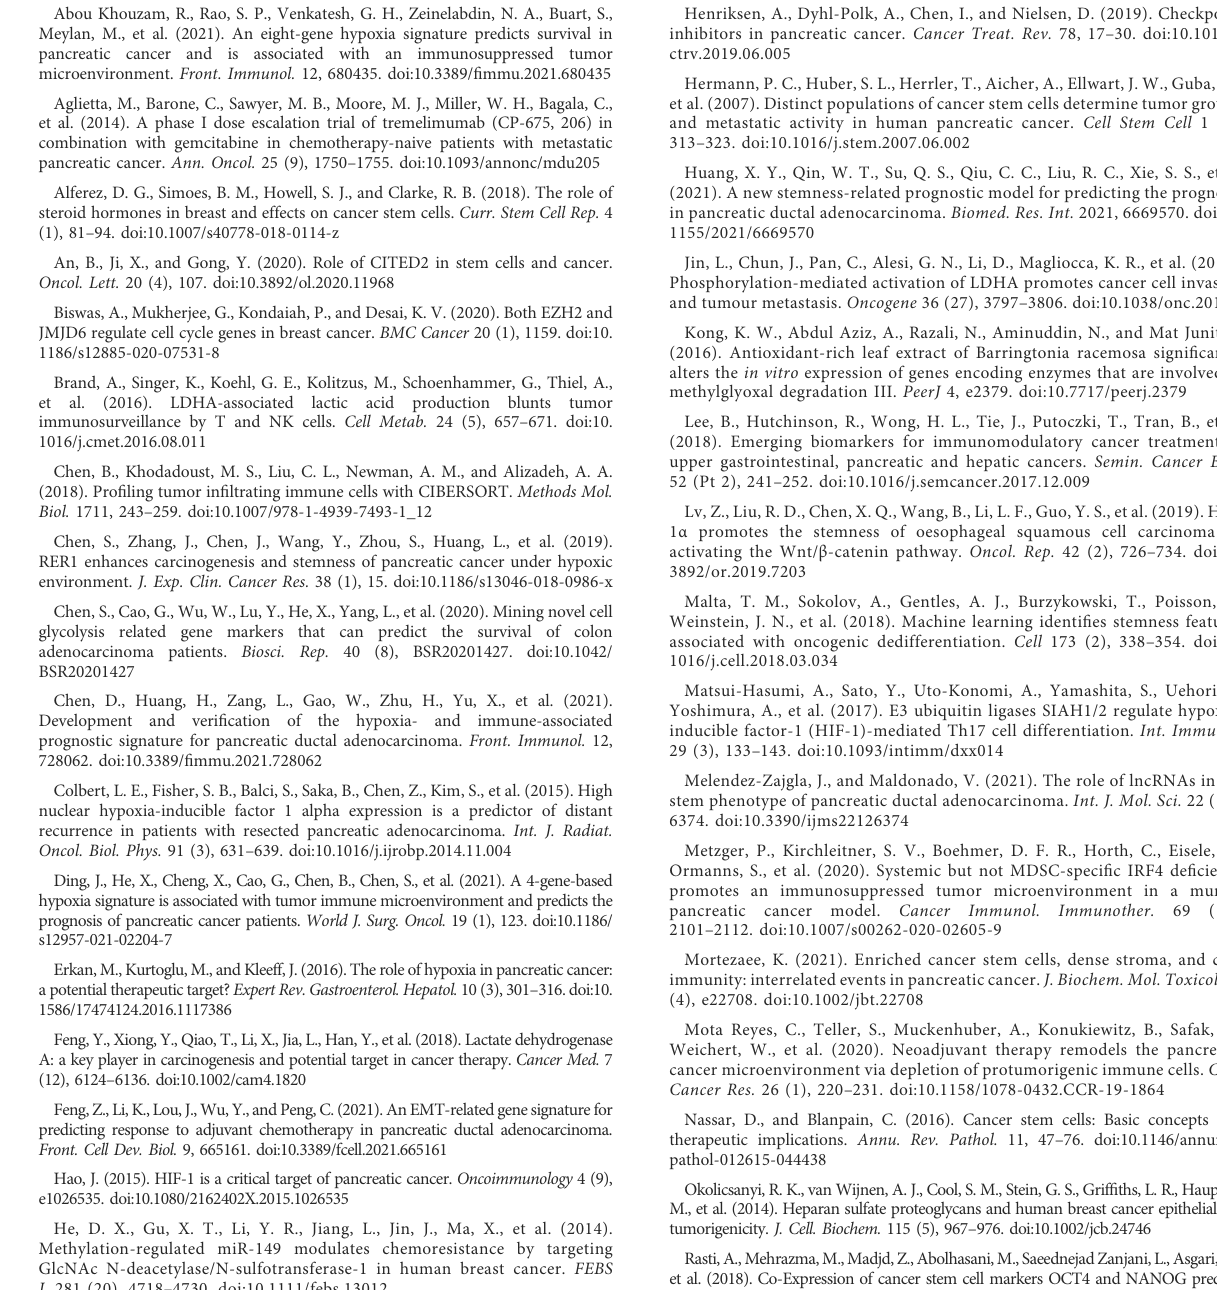
are lambda.min and lambda.lse. (B) LASSO coef fi cient pro fi les of eight OS-related genes with nonzero coef fi cients determined by the optimal lambda. SUPPLEMENTARY TABLE S2 The 108 hypoxia genes signi fi cantly associated with mRNAsi. SUPPLEMENTARY TABLE S3 The 45 HSRGs strongly correlated with OS of PAAD